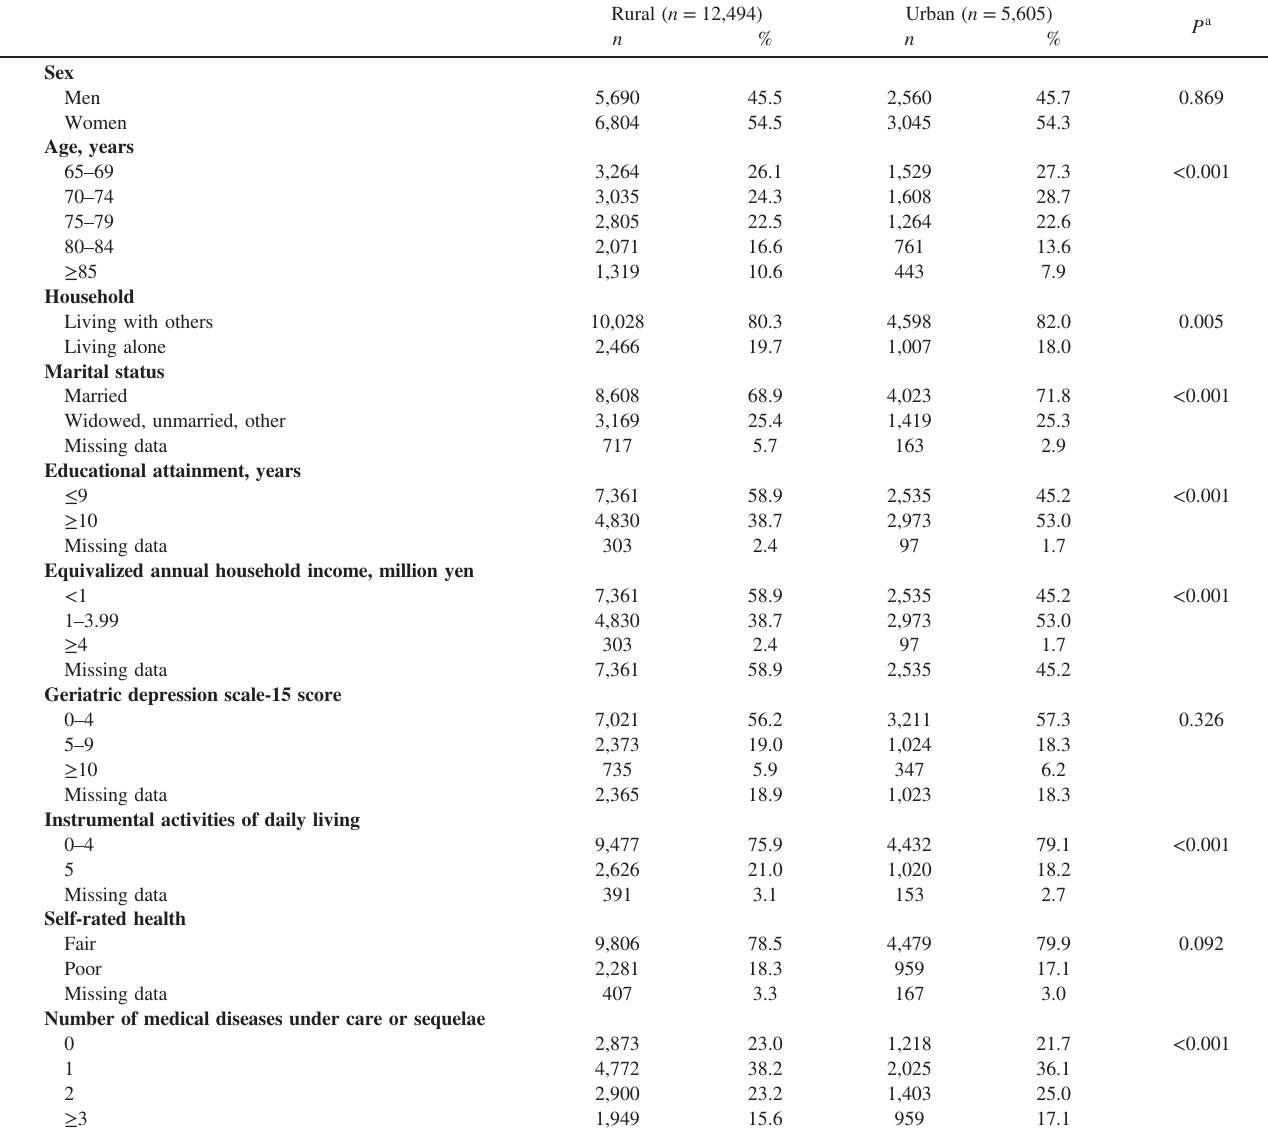
Table 2. Participants ’ demographic characteristics by rural and urban